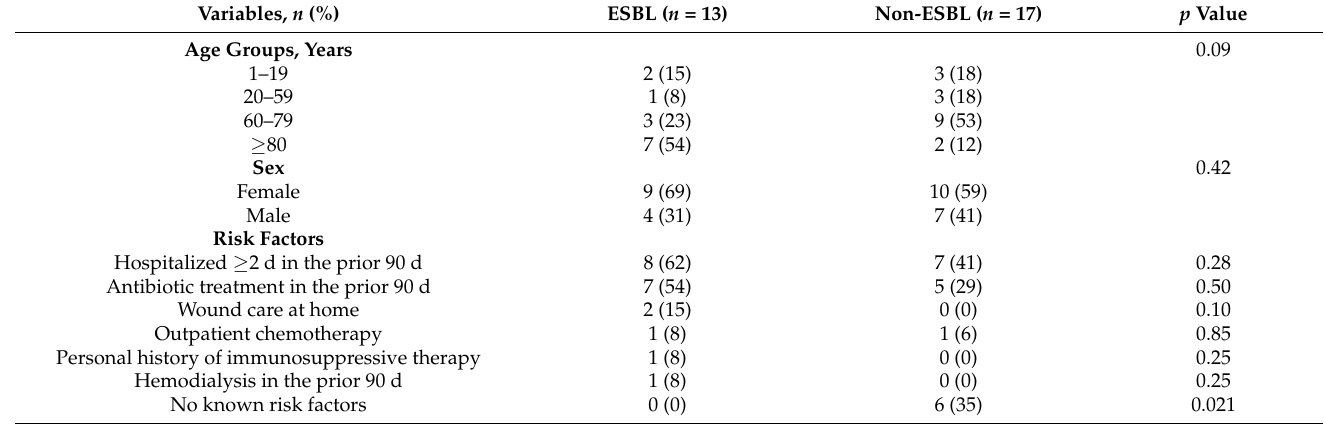
Table 2. Identification of risk factors potentially associated with infections by ESBL-producing Escherichia coli . Variables, n